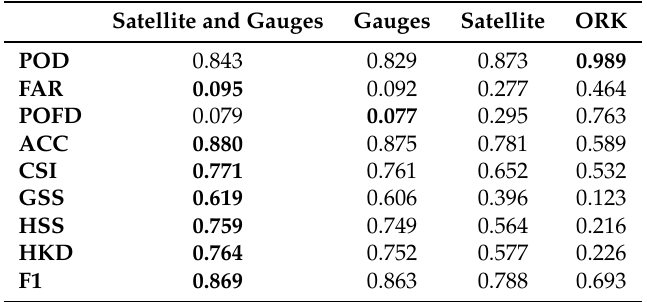
Table 9. Daily precipitation detection scores averaged on the climatological test gauges, for the test days.